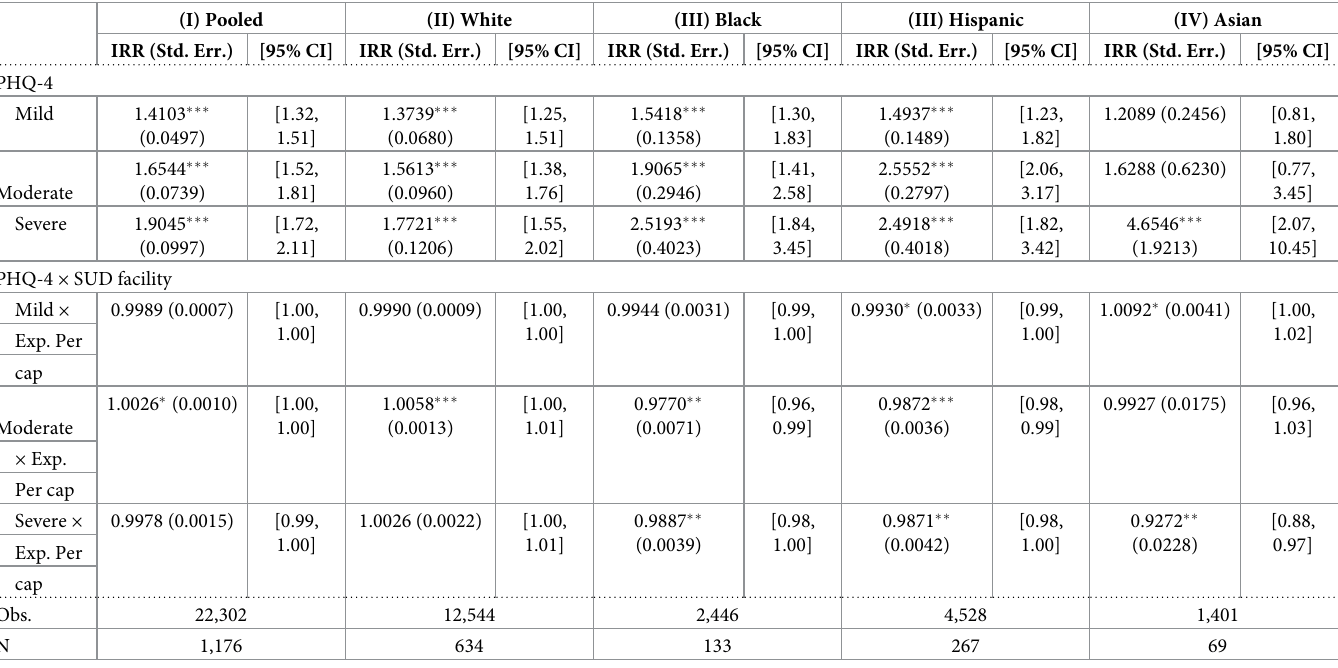
Table 2. Effects of SUD facility spending and anxiety/depression on drug